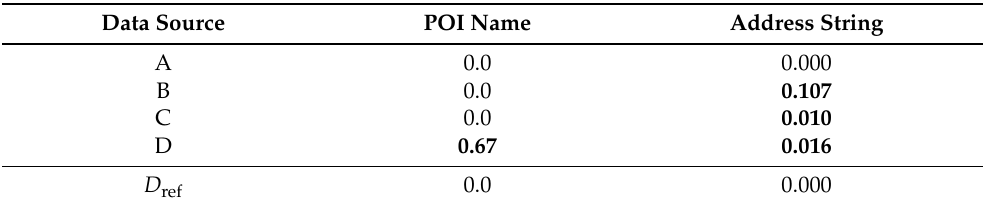
Table 5. Proportion of POIs with missing attributes. None of POIs have missing coordinates and place types. These attributes were excluded from